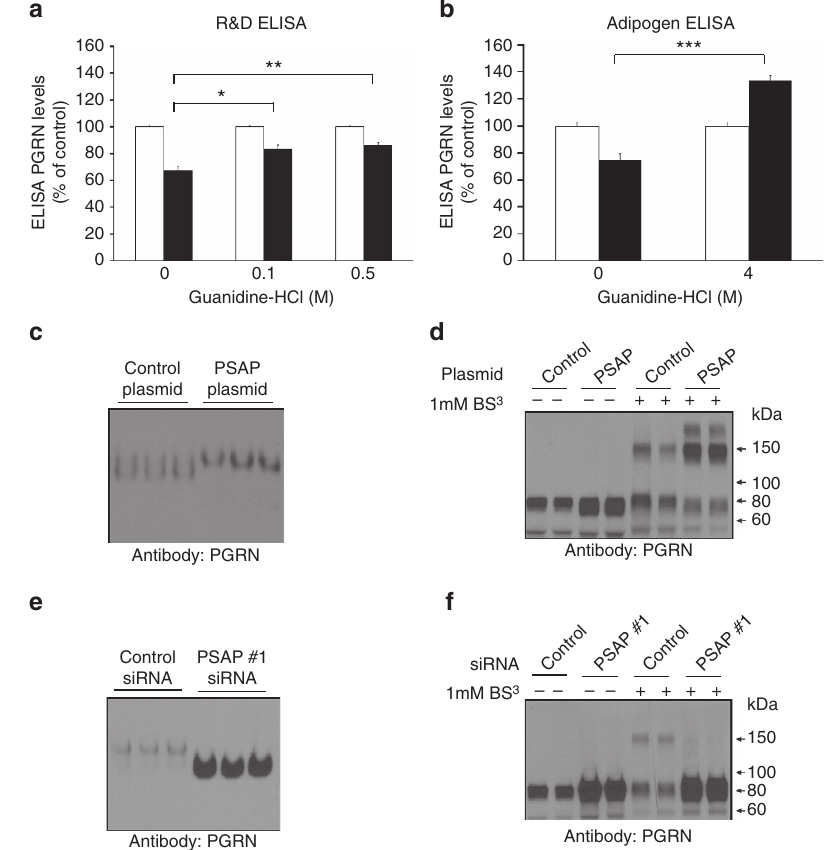
Figure 7 | Increasing PSAP levels results in changes in PGRN oligomerization. ( a , b ) R&D ( a ) or Adipogen ( b ) PGRN ELISA measurements in HeLa media from control- (white bars) or PSAP-transfected (black bars) cells after a 3-h incubation with or without guanding-HCl ( n ¼ 3 per group). ( c ) Native gel of media from HeLa cells transfected with either a control PSAP overexpression plasmid. ( d ) Immunoblot of media from HeLa cells transfected with either a control or PSAP plasmid that had been treated with ( þ ) or without ( (cid:3) ) 1mM BS 3 . ( e ) Native gel of conditioned media obtained from HeLa cells transfected with a control or PSAP siRNA. ( f ) Immunoblot of control or PSAP siRNA-transfected HeLa cell media after treatment with ( þ ) or without ( (cid:3) ) BS 3 crosslinker. Graphed values represent the mean ± s.e.m. *Differs from 0M guanidine-HCl treatment, P o 0.05; ** P o 0.01; *** P o 0.0001 by one-way ANOVA ( a ) or Student’s t -test ( b